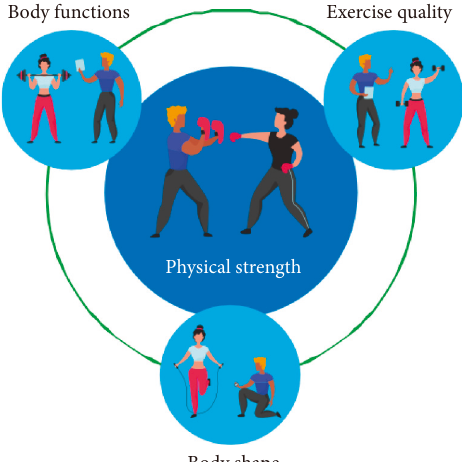
Figure 1: The influence of Wushu athlete’s body